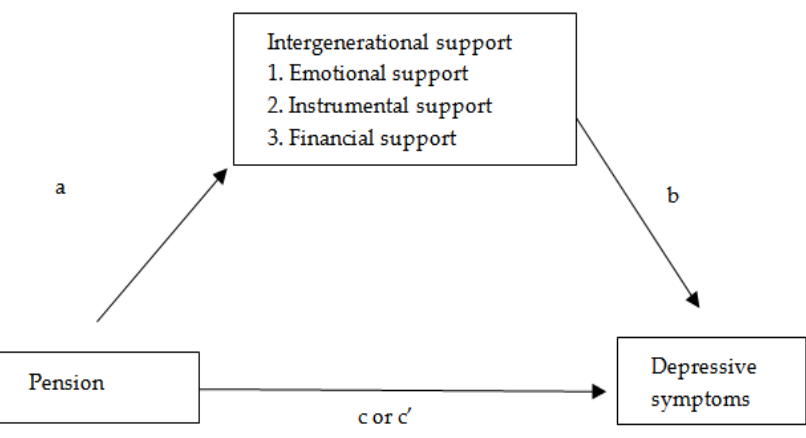
Figure 1. Conceptual framework of this study.